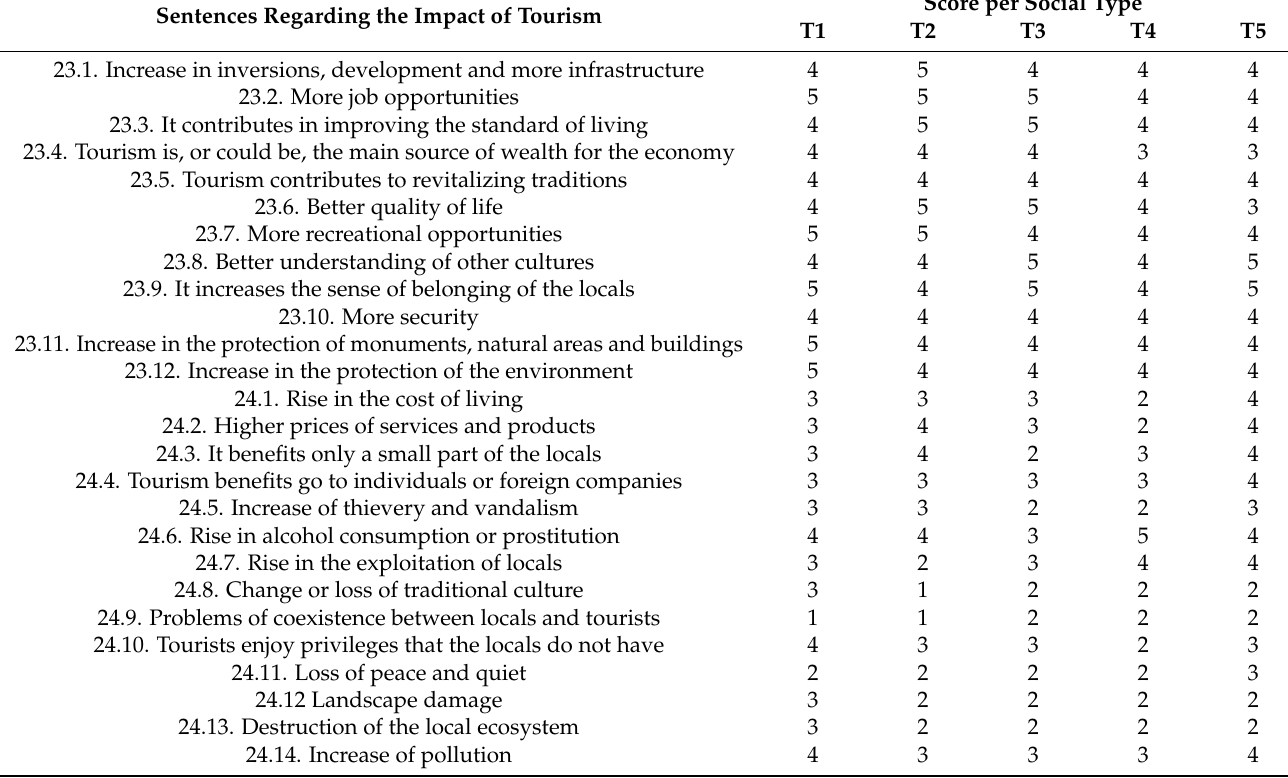
Table A2. Results of questions 23 and 24 of the survey, regarding the perception towards the impacts of tourism. The participants were asked to score from 1 to 5 the following sentences, where 1 means “completely disagree” and 5 “completely agree”. The mean scores for each type of stakeholder (T1–T5) are shown in the